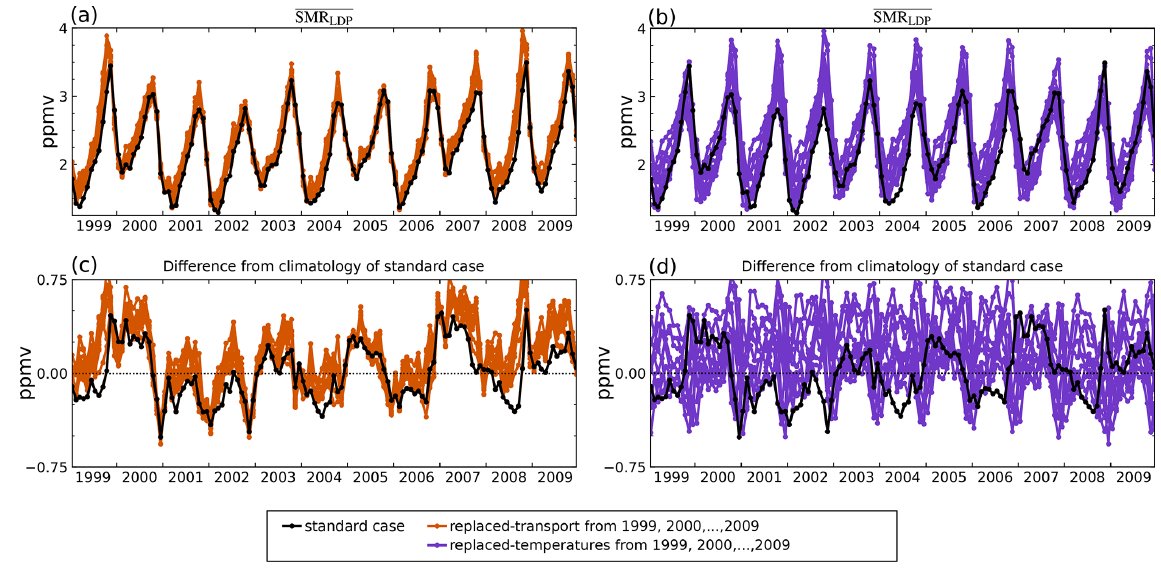
Figure 2. Time series of SMR LDP for the standard case (black) and for replacement calculations. The 11 orange lines display cases of replaced transport from each of the other years in 1999–2009, and the 11 purple lines display cases of replaced temperatures. (a, b) Absolute concentrations. (c, d) Anomaly from the mean annual cycle of the standard case.